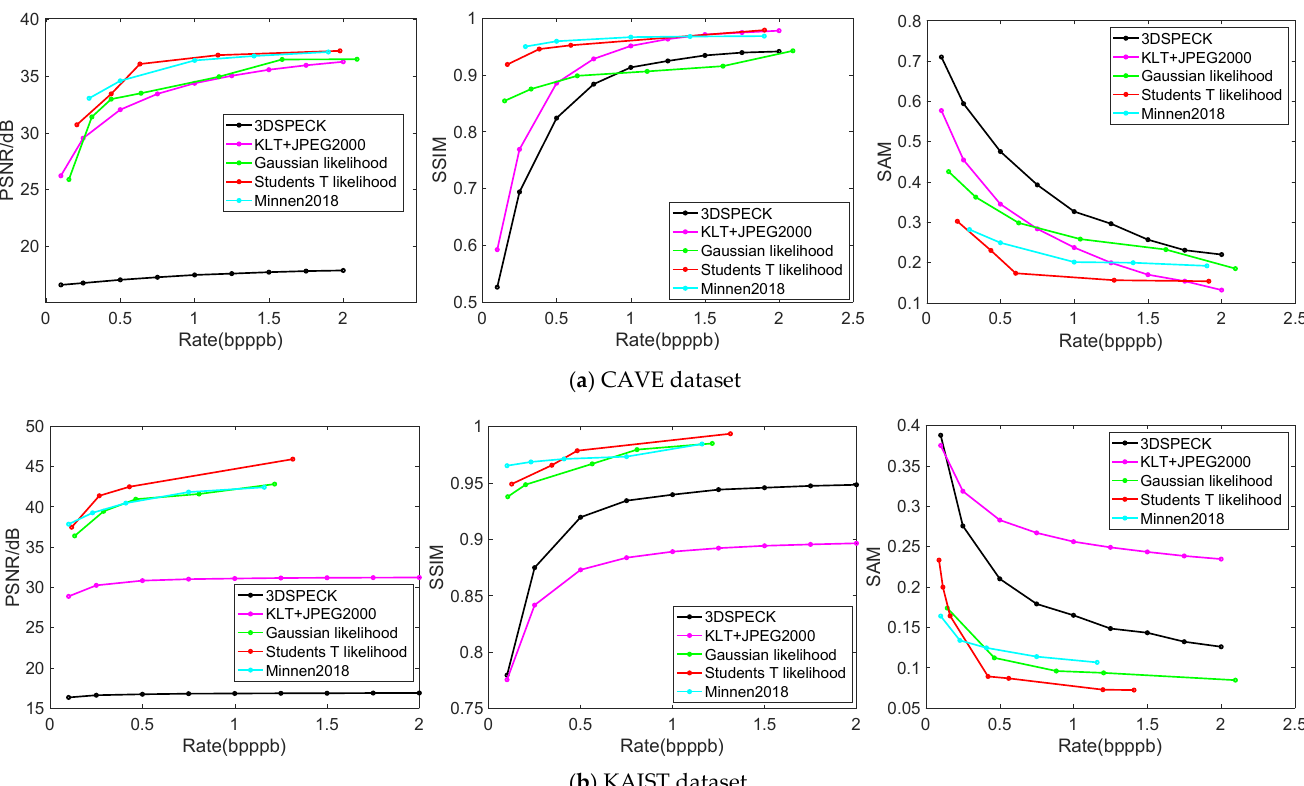
Figure 8. Rate-distortion performance displayed over CAVE and KAIST datasets. The left plots show average PSNRs. The middle plots show average SSIMs, ranging from zero and one. The right plots show average SAMs. ( a ) Rate-distortion performance displayed over CAVE; ( b ) Rate-distortion performance displayed over